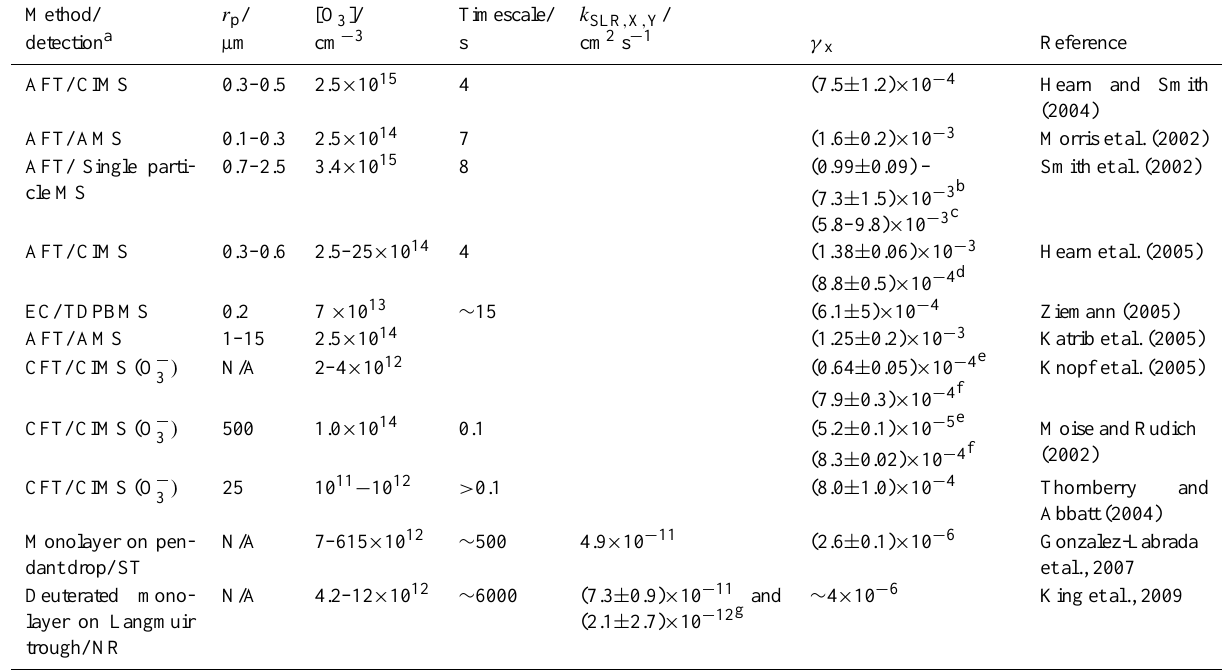
Table 1. Experimental conditions and results of laboratory studies investigating the reactive uptake of ozone by oleic acid (compare Tables 1 and 2 in Zahardis and Petrucci, 2007; Gonzalez-Labrada et al., 2007 and King et al., 2009).